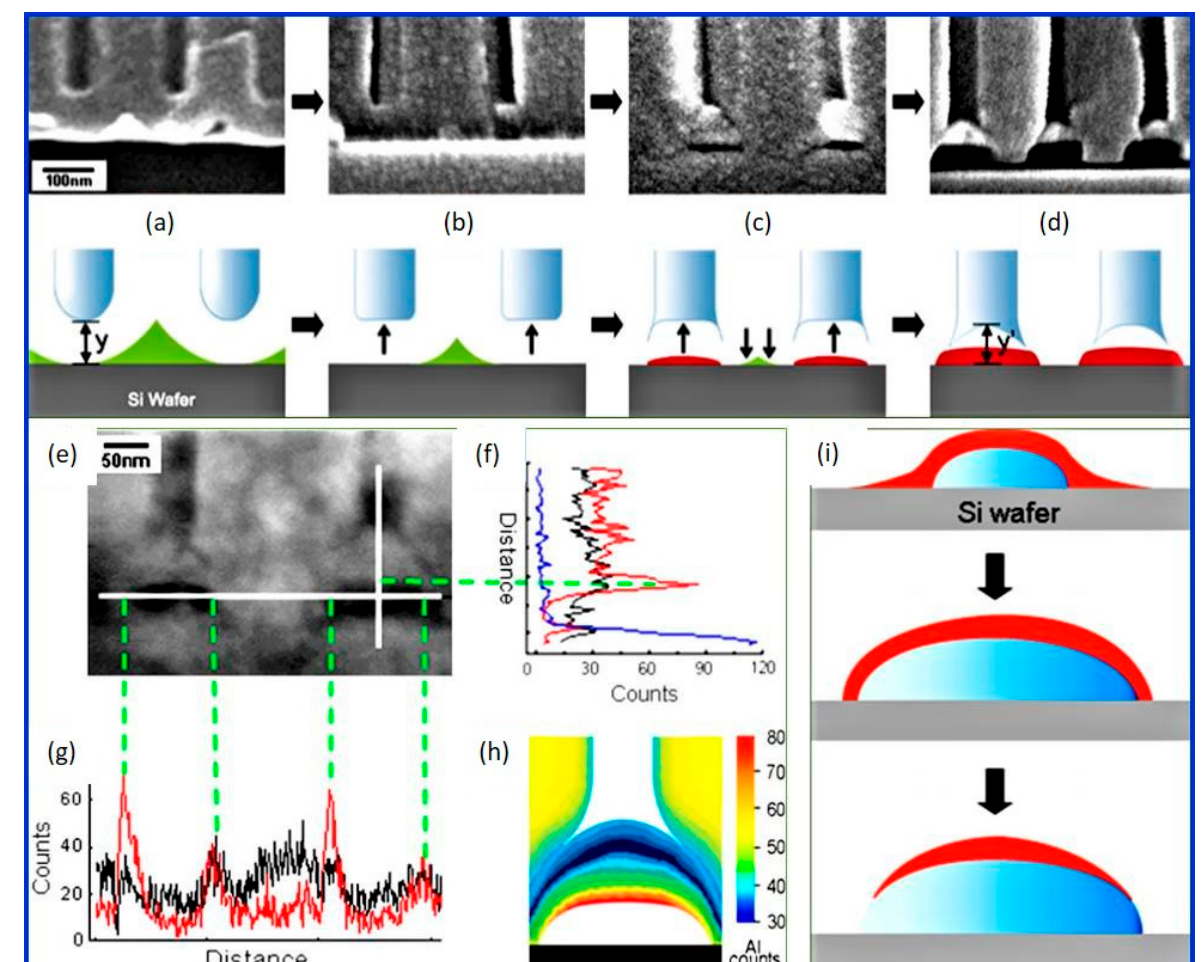
Figure 4. ( a – d ) Cross-sectional SEM images and cartoons depicting the process of void formation. ( a ) Residual Al (green) when the barrier layer touches the Si substrate (grey); ( b ) a pore-bottom shape changes due to the stresses generated by the bottom alumina; ( c ) stress-release by void (red) formation; ( d ) angular pore-bottom due to the void growth as anodization continues; ( e ) TEM image and representative line scans ( f , g ) obtained by nanoprobes EDS around voids; ( f ) vertical scan of Al (red), O (black), and Si (blue); ( g ) horizontal scan of Al (red) and O (black); ( h ) 2D reconstruction of Al concentration; ( i ) schematic explaining the formation of Al-rich alumina during void growth. Reprinted with permission from Hong-Seok Seo, Yang-Gyoo Jung, Sang-Won Jee, Jun Mo Yang, and Jung-Ho Lee, Scripta Materialia 57 (10), 968 (2007). Copyright 2007 Elsevier [104] .